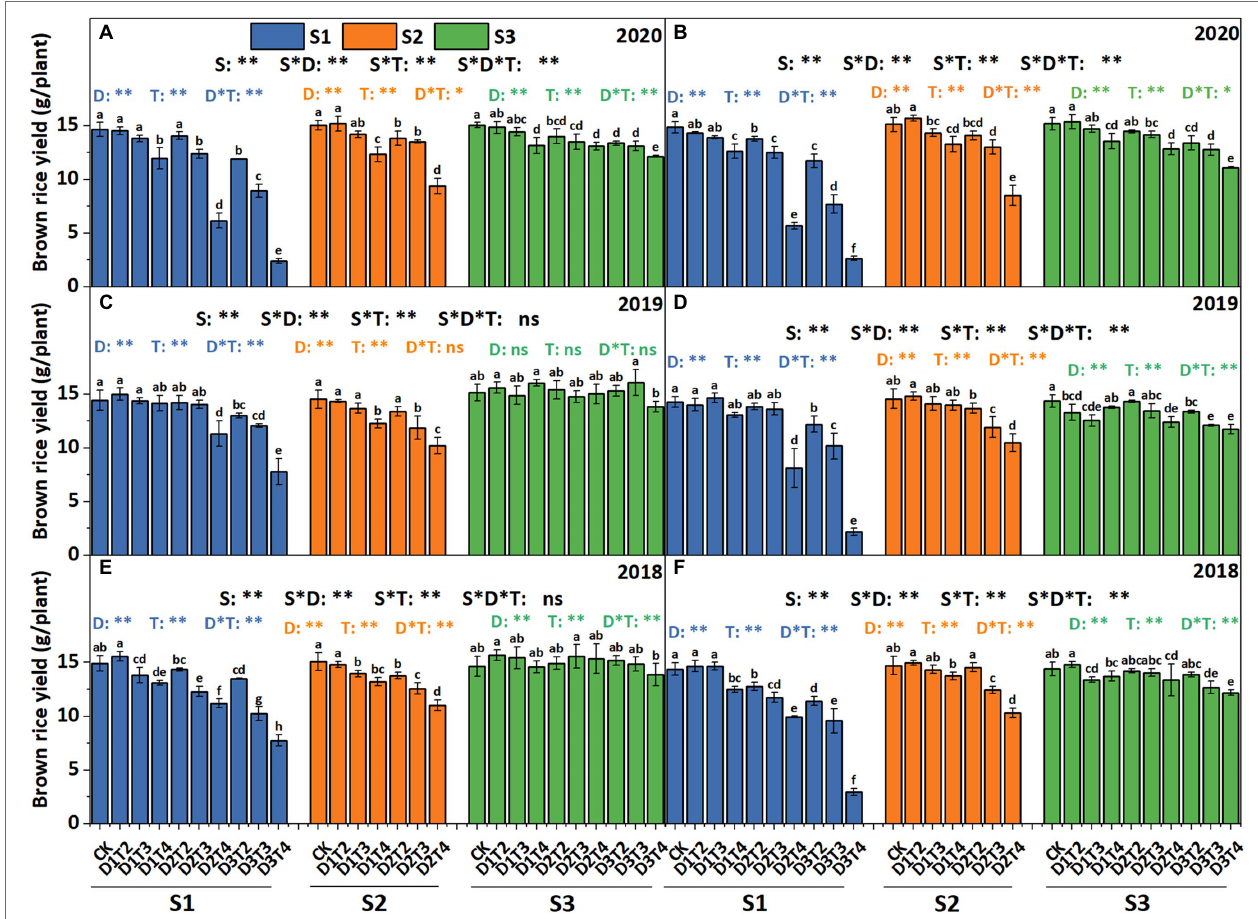
FIGURE 2 | Yield of brown rice under different LTS treatments in Huaidao 5 (A,C,E) and Nanjing 46 (B,D,F) at maturity. S1, S2, and S3 represent the early stage of flowering, peak stage of flowering, and grain filling stage, respectively. CK indicates the control. The bars with the same lowercase letter(s) indicate no significant differences among different treatments at p < 0.05. * and ** indicate significant effects at p < 0.05 and p < 0.01 levels,